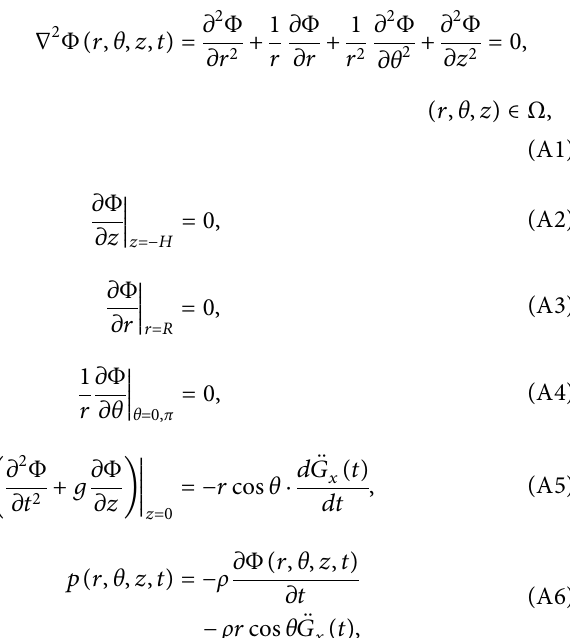
/ H vs. the fluid depth ratio H / R 0